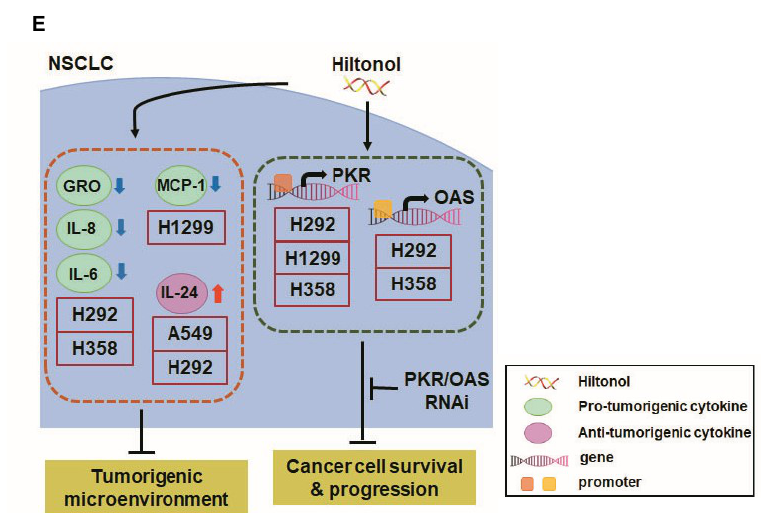
Figure 7. PKR, OAS, and IL-24 proteins which are expressed in normal tissues are suppressed in human primary lung cancer tissues. ( A ) Box-whisker plot showing the transcript levels of PKR, OAS, and IL-24 in TCGA database, respectively. Both AD (adenocarcinoma) tissues ( n = 509), SCC (squamous cell carcinoma) tissues ( n = 498) and normal tissues ( n = 58 for AD group and n = 51 for SCC group) were used for analysis. Data are reported as normalized counts as provided in the TCGA level 3 data (**, p < 0.01). ( B ) Retrospective staining of patient lung cancer (“C”) and paired normal (“N”) tissues for PKR, OAS, and IL-24 was performed for lung cancer stages I, II, III, and IV. Clinicopathological parameters are shown in Supplementary Figure S6. Inflammatory cell infiltration is indicated with yellow arrows. The protein levels of tumor suppressor markers, PKR and OAS, are dramatically reduced in carcinoma tissues, compared to normal controls. Consistently, anticancer cytokine, IL-24, showed a clear reduction in lung cancer tissues. Scale bar; 100 µ m. ( C ) The corresponding quantitative results of IHC (immunohistochemistry) of PKR, OAS, and IL-24 are shown. ( D ) A hypothetical model to illustrate PKR activation via interaction with